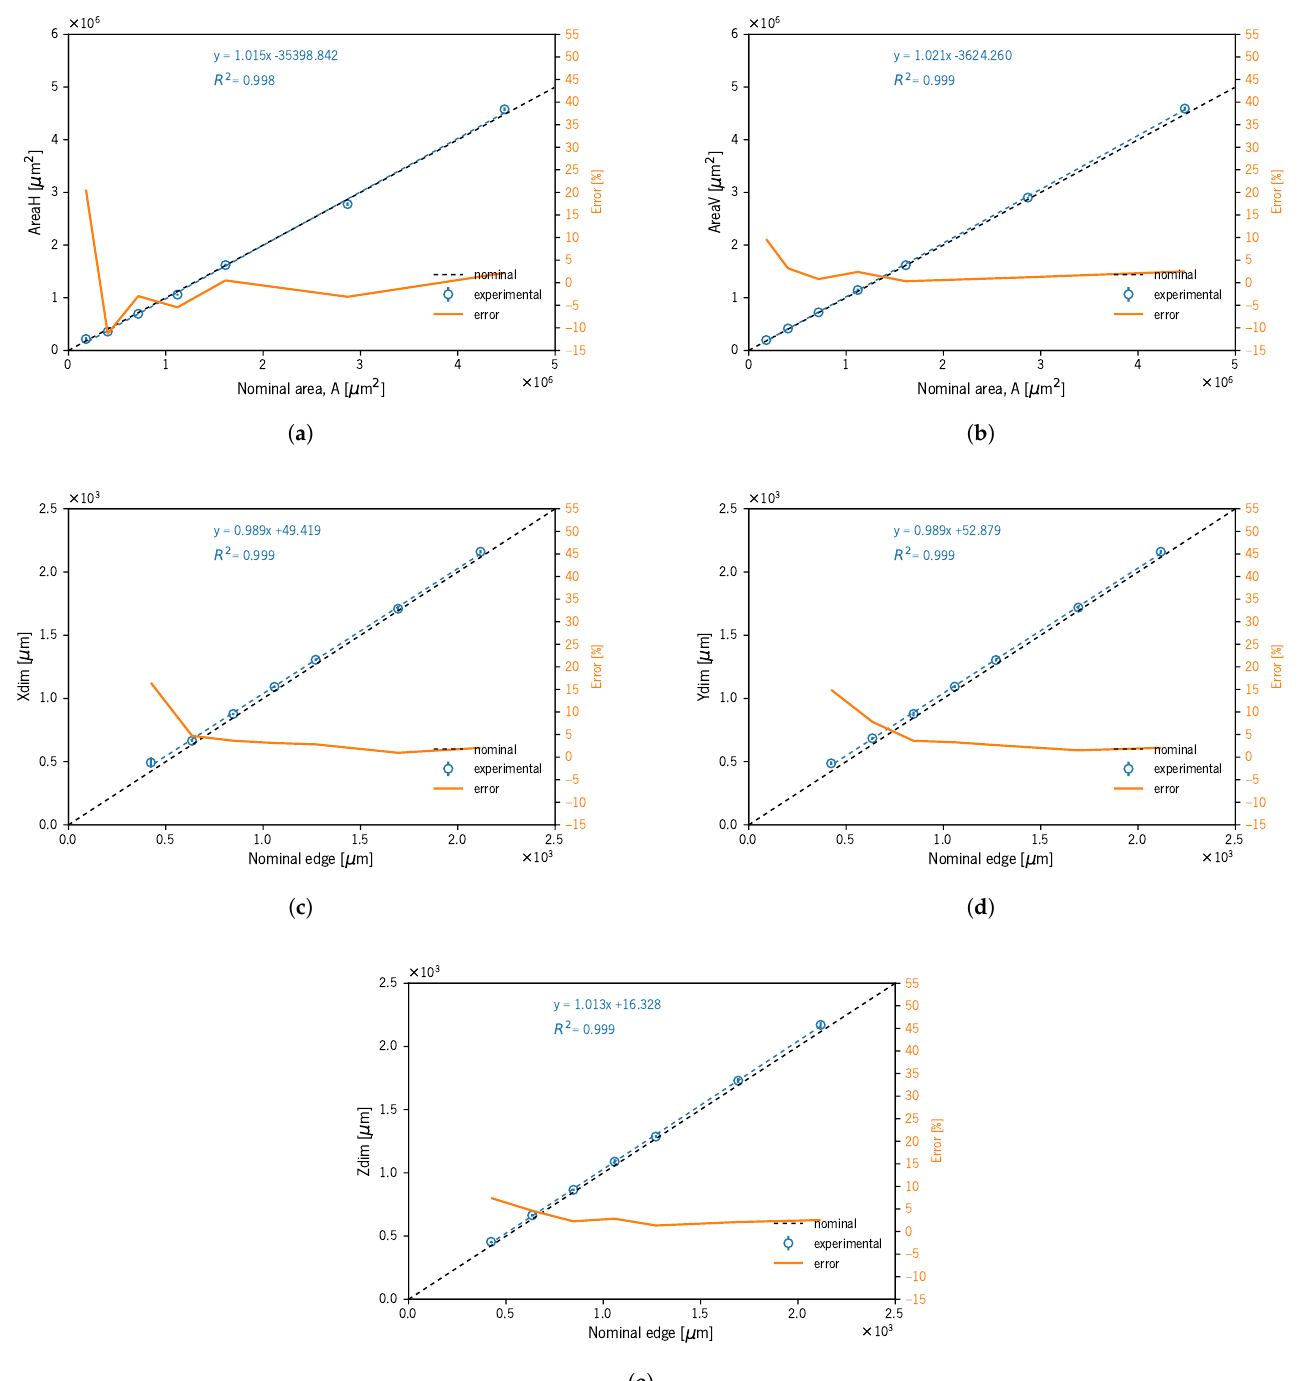
Figure 6. Experimental mDs’ measurement diagrams with linear fit and relative error for specimens A01 to A07: ( a ) AreaH; ( b ) AreaV; ( c ) XDim; ( d ) YDim; ( e )